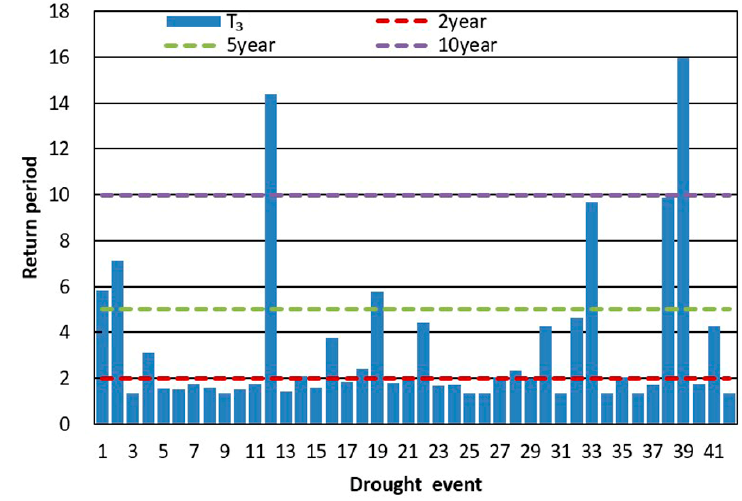
Figure 10. The return period of the 3D drought event.